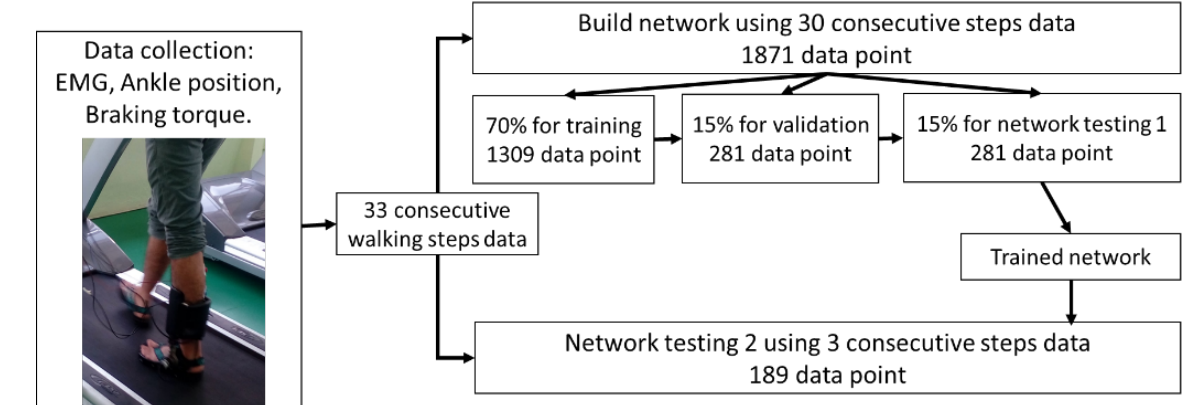
Figure 3: Data collection and